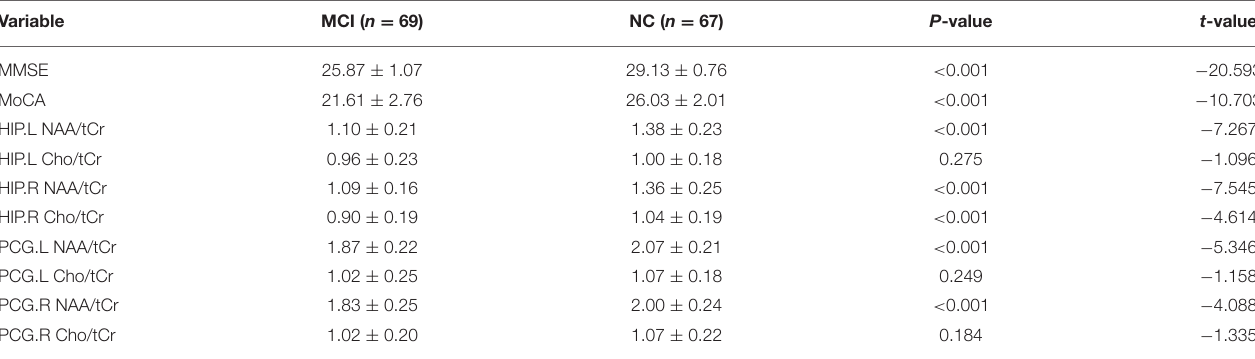
TABLE 2 | MRS test results and cognitive scale scores by diagnostic group ( N =